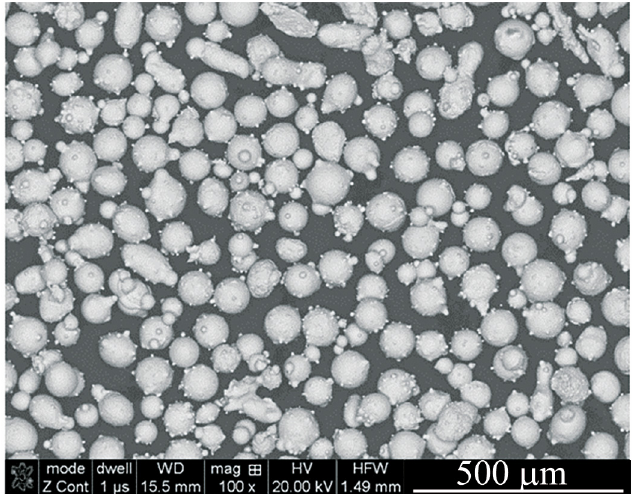
Figure 1. Morphology of Co-6 feedstock powder.